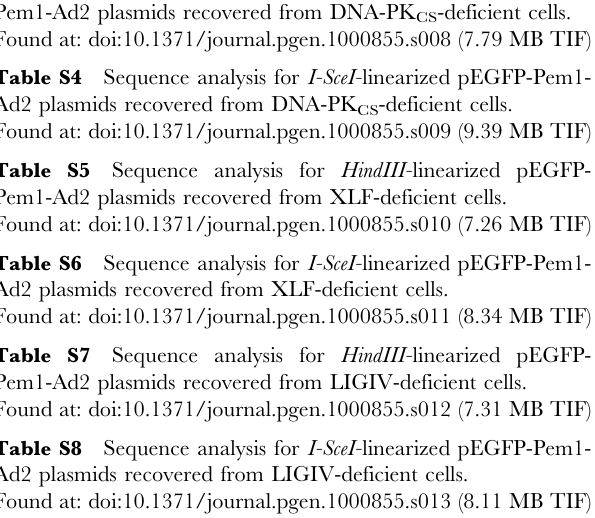
Table S2 Sequence analysis for I-SceI-linearized pEGFP-Pem1- Ad2 plasmids recovered from Ku-deficient cells.